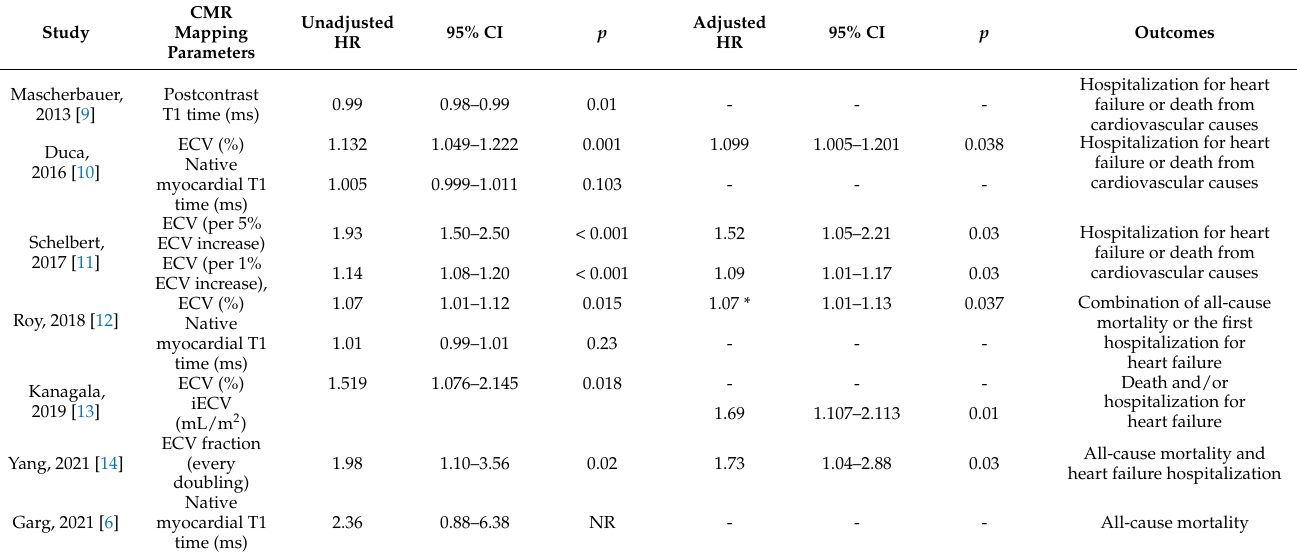
Table 3. Estimated changes in myocardial T1 parameters and corresponding HR values from Cox univariate/multivariate proportional hazard